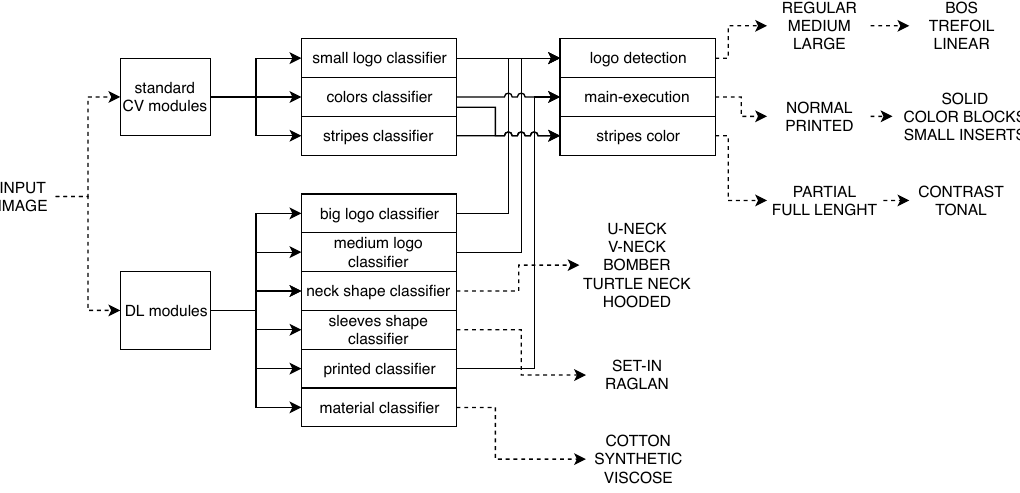
Figure 5. Detailed organization of system modules. Uppercase statements highlight inputs and outputs, while boxed ones emphasize the actual modules of the system. Solid arrows denote conceptual connections among modules, while dashed arrows denote inputs or